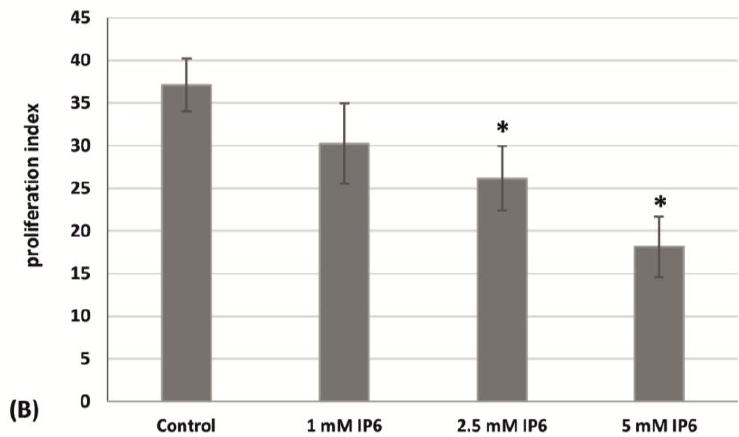
Figure 2. ( A ) The cell cycle distribution of the control and Caco-2 cells treated with 1 mM, 2.5 mM and 5 mM InsP6 for 48 h (the means ± SD; * (sub-G1), ^ (G1/G0), # (S phase), $ (G2/M) p < 0.05 vs. control). ( B ) Proliferation index of Caco-2 cells treated with InsP6 (the means ± SD; * p < 0.05 vs. control).